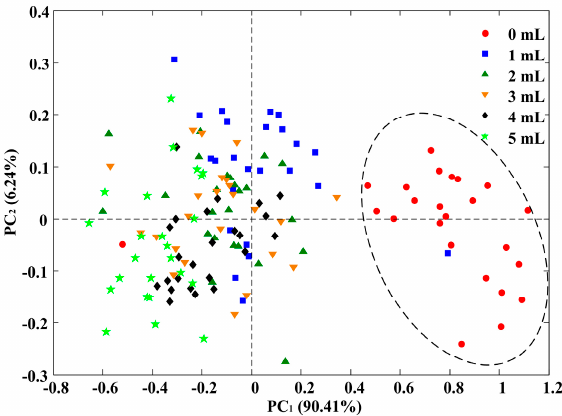
Figure 3. Principal component analysis (PCA) score plot of PC 1 versus PC 2 based on A spectral unit.